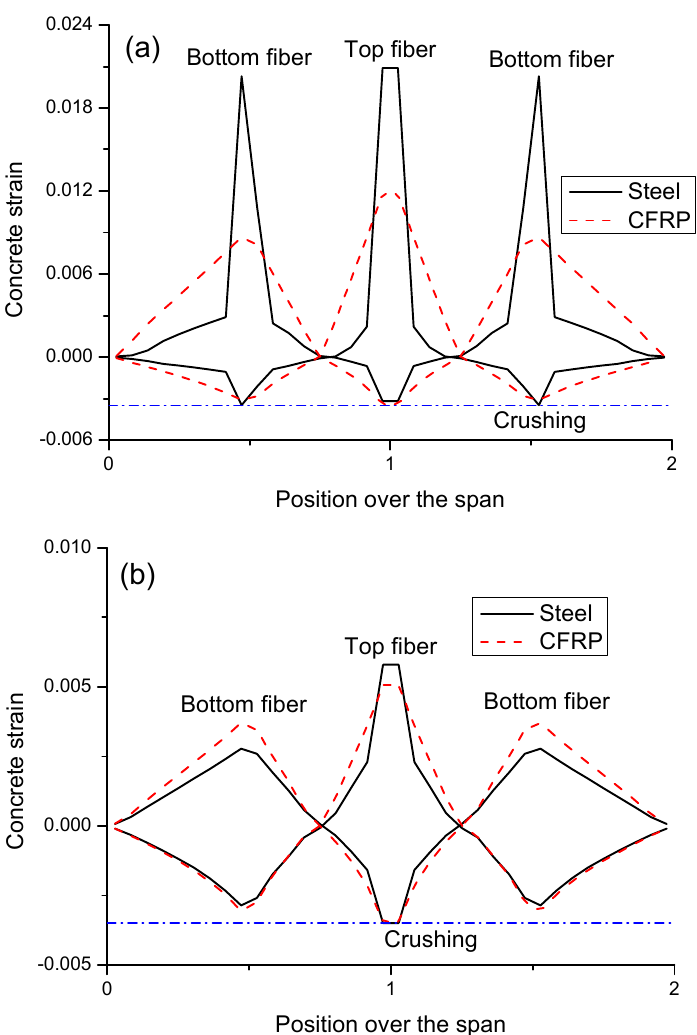
Figure 4. Concrete strain distribution in failure: ( a ) ρ b 2 = 0.61%; ( b ) ρ b 2 = 2.42%.